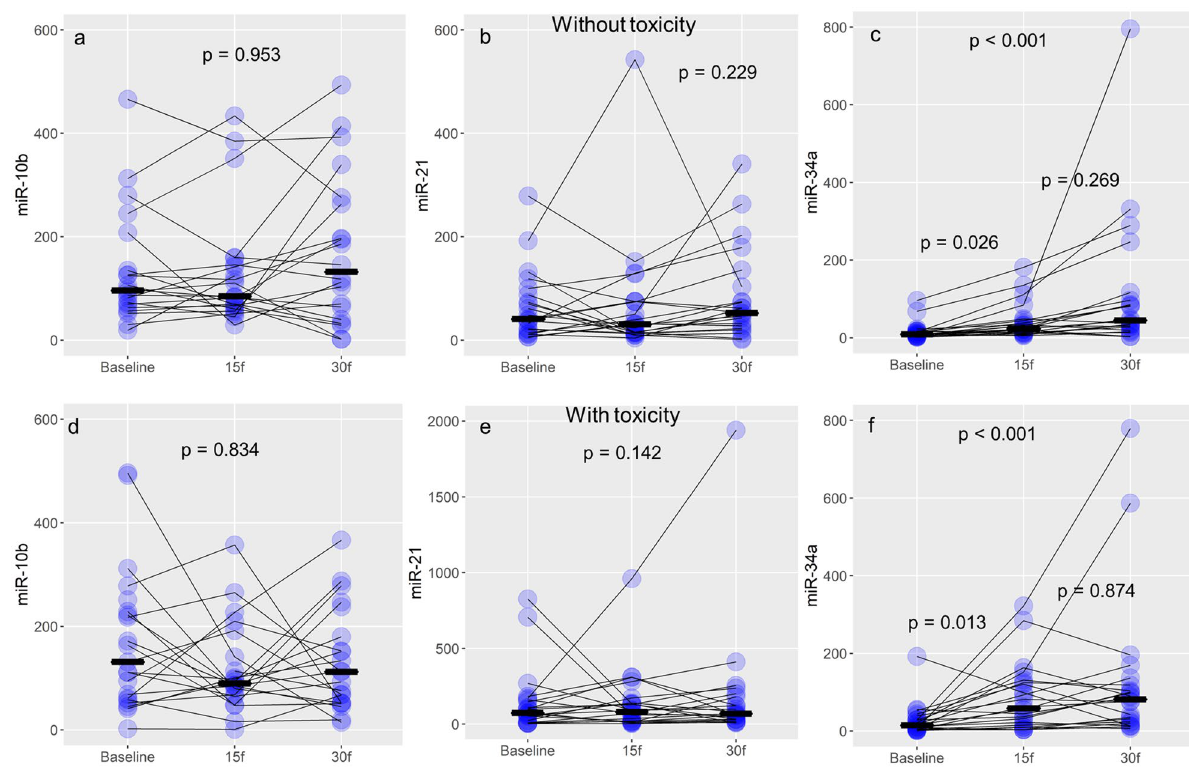
Figure 3. Changes of miR-10b/21/34a over time during the treatment. Violet dots represent each patient, while the black line represents the median value of expression ( RQ relative quantity units) for miR-10b (a-without toxicity, and d-with toxicity), miR-21 (b-without toxicity, and e-with toxicity), and miR-34a (c-without toxicity, and f-with